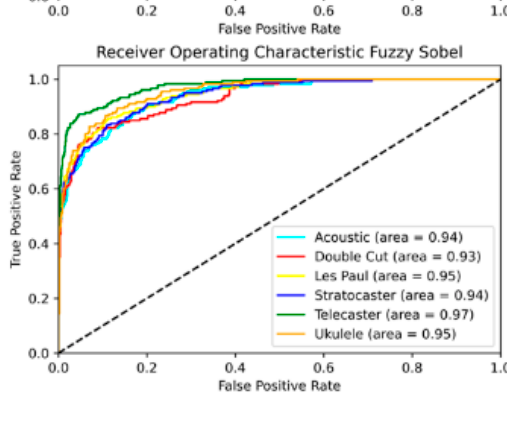
Figure 11. ROC curve for CNN-II.